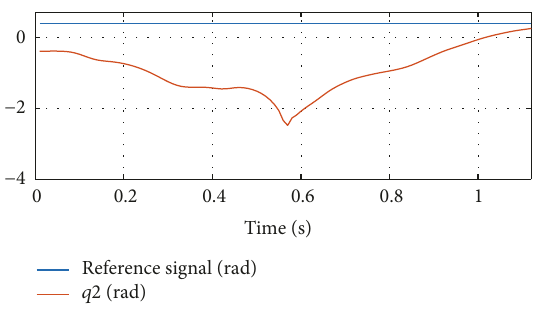
Figure 15: Trajectory of 𝑞 2 (rad).